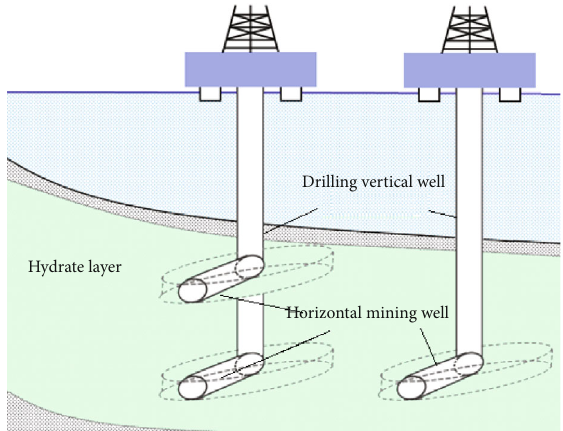
Figure 5: Schematic diagram of drilling vertical wells and producing horizontal wells.